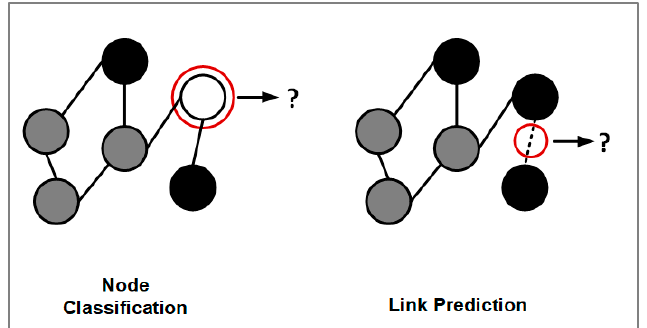
Figure 5. Different tasks of graph machine-learning models.